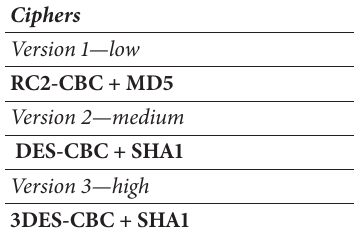
Table 1: Selection of the specific cryptographic algorithms.